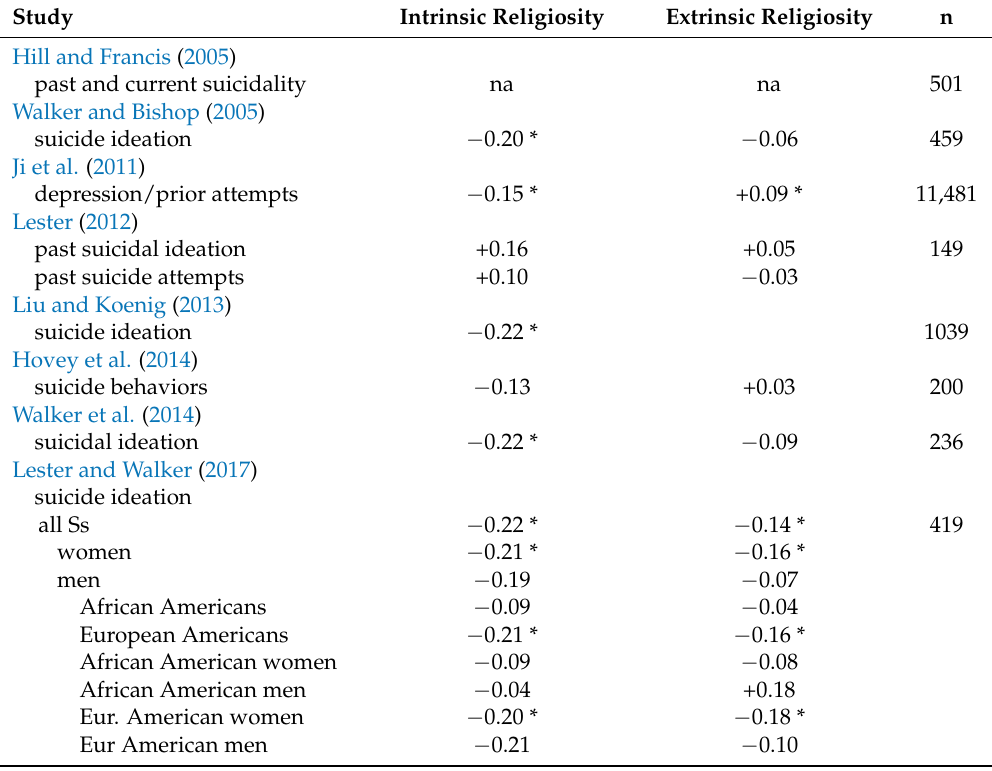
Table 2. Research using intrinsic-extrinsic religiosity scales (Pearson correlations